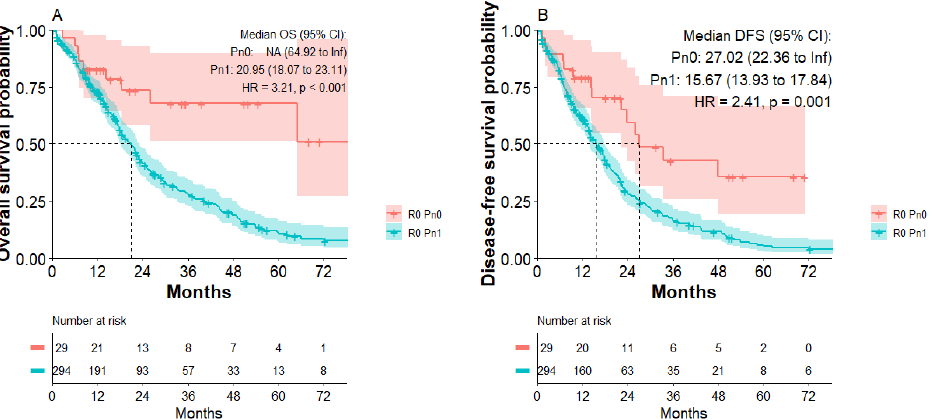
Figure 2. Overall survival and disease-free survival of patients with R0 Pn0 and R0 Pn1 tumors. ( A ) Overall survival of R0 Pn0 and R0 Pn1 group. ( B ) Disease-free survival of R0 Pn0 and R0 Pn1 group.